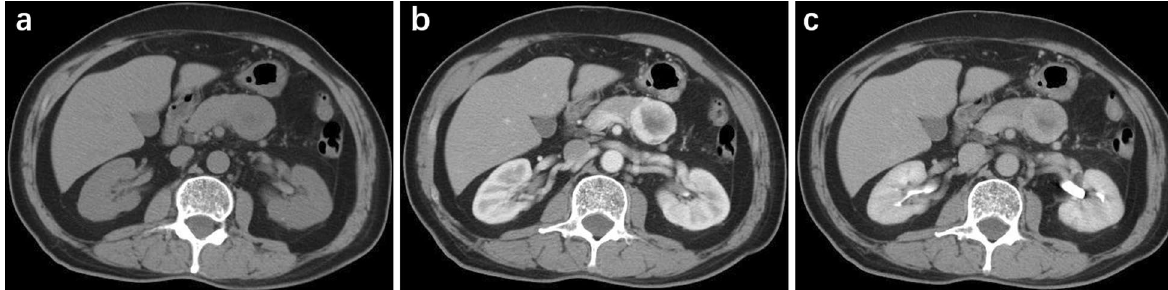
Fig. 4 NET of the pancreatic body in a 72-year-old man. a Unenhanced CT scan shows a well-defined solid and cystic mass with a size of 3.5 cm. The CT value of the tumor is 41 HU. b Arterial phase CT scan shows marked heterogeneous enhancement of the lesion with a rim type. The CT value of the tumor is 133 HU. c Portal phase CT scan shows areas of washout. The CT value of the tumor is 98 HU